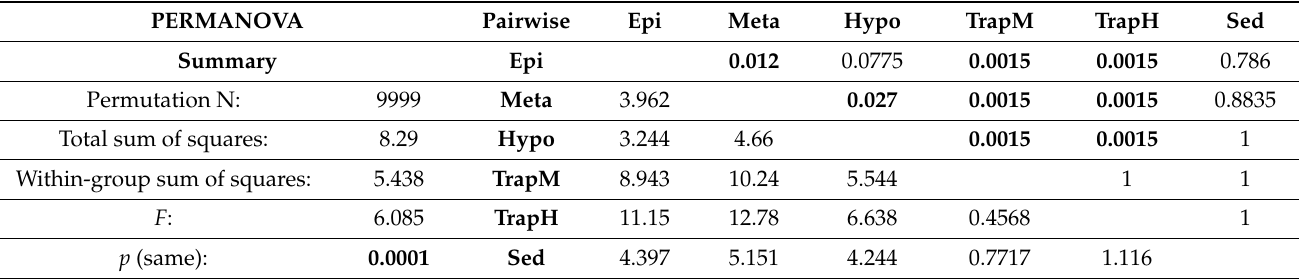
Table 1. One-way PerMANOVA on cyanobacterial communities grouped into epi-, meta-, and hypolimnion in the water column, meta-, and hypolimnion of the sediment traps and surface sediments. Summary presents overall test statistics. Pairwise analysis shows Bonferroni corrected p -values (values in bold are significant at p < 0.05) above the diagonal and corresponding F -values below. Where ‘W’ indicates water column samples from the epi-, meta- and hypolimnion. The ‘ST’ indicates sediment trap material from the meta- and hypolimnion and ‘Sed’ represents the surface sediment samples. PERMANOVA Pairwise Epi Meta Hypo TrapM TrapH Sed